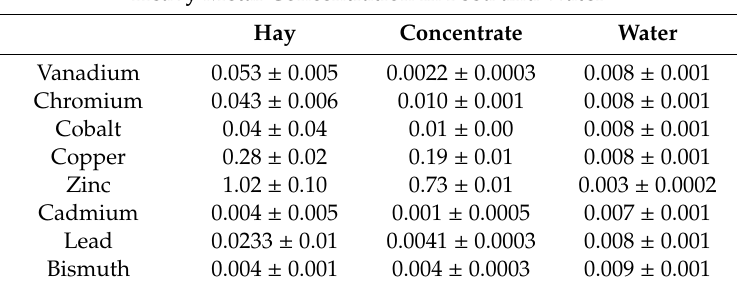
Table 1. Heavy metal parameters (mean ± SD) of horse-fed hay and concentrate together with the water values (mg / Kg of dry